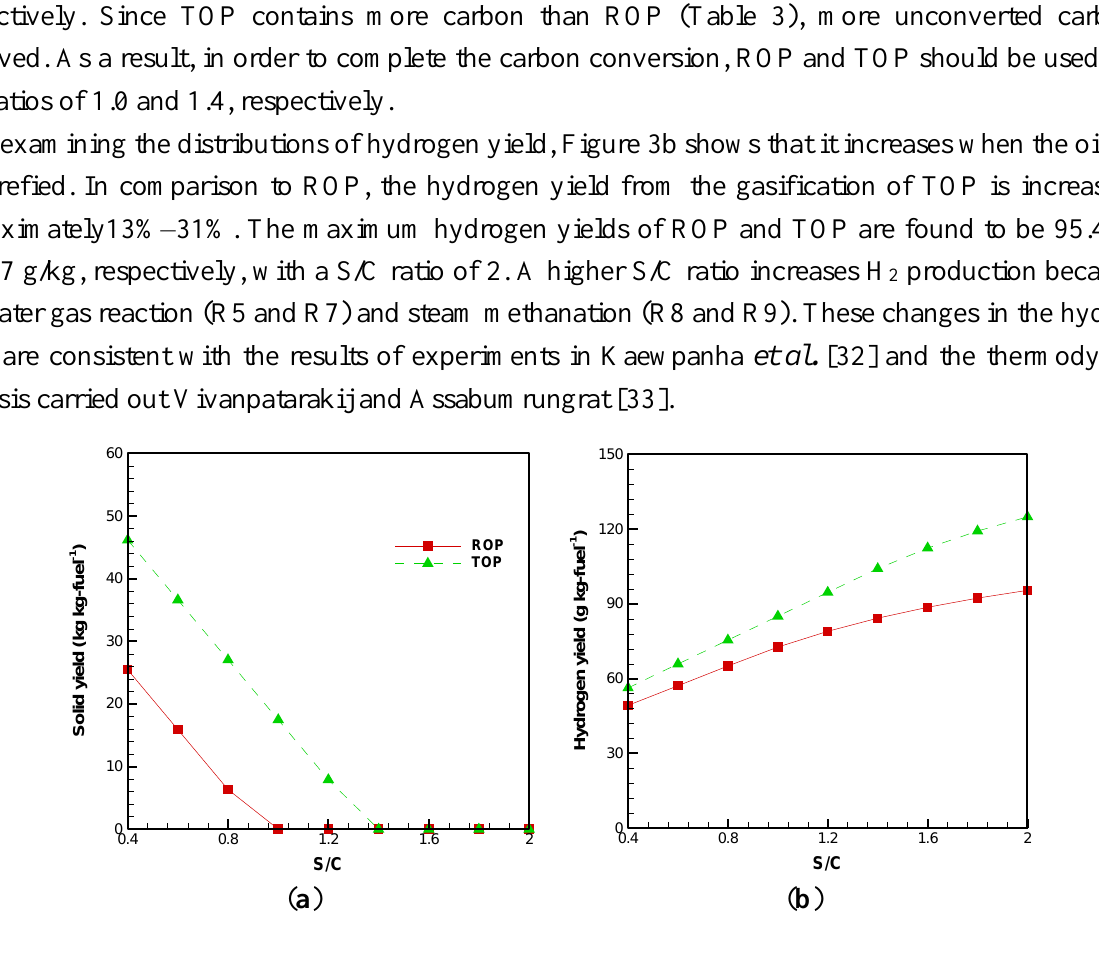
Figure 3. Effects of the S/C ratio on ( a ) solid yield and ( b ) hydrogen